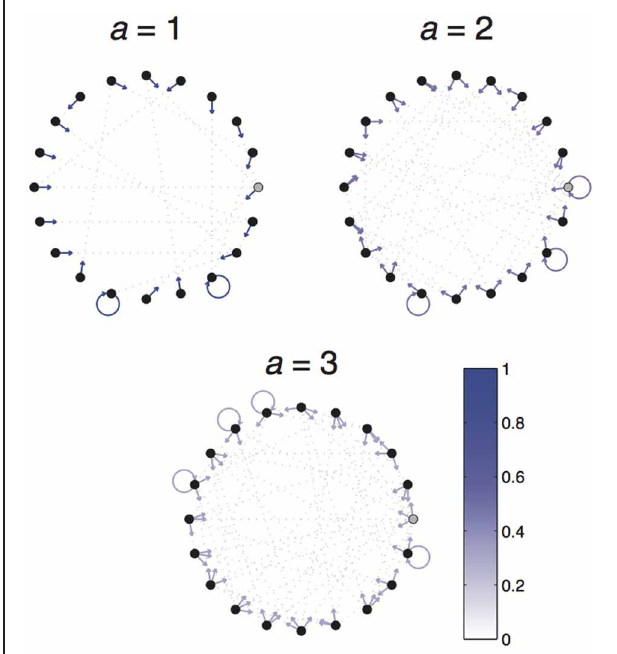
FIGURE A2 | Example 1-2-3 World. 1-2-3 Worlds consist of 3 actions (separately depicted) and 20 states (depicted as nodes of the graphs). The transition probabilities associated with taking a particular action are depicted as arrows pointing from the current state to each of the possible resultant states. Arrow color depicts the likelihood of each transition. The absorbing state is depicted in